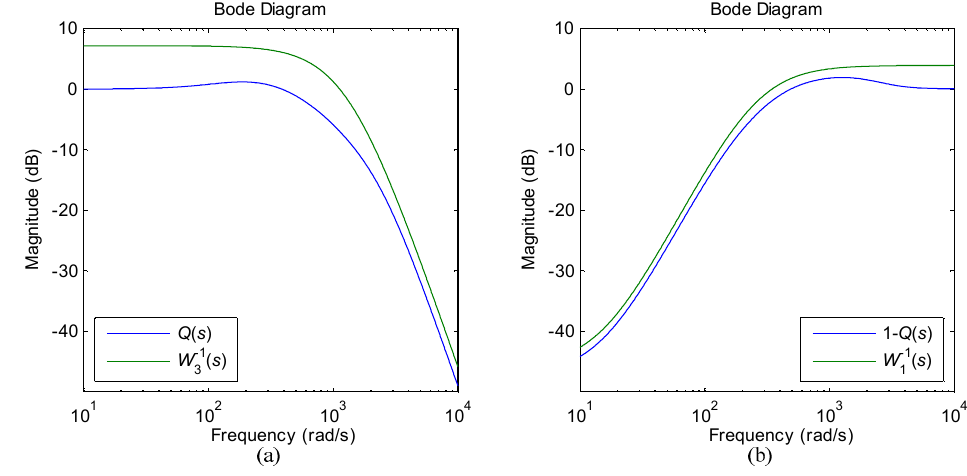
( ) W s  ; ( b ) Frequency magnitude p s q ; ( b ) Frequency magnitude responses 3 3